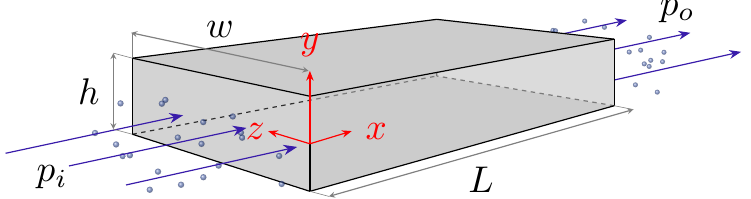
Figure 1. Schematic of pressure driven flow of a rarefied gas through a micro-channel of length L , height h and width w ( L , w (cid:29) h